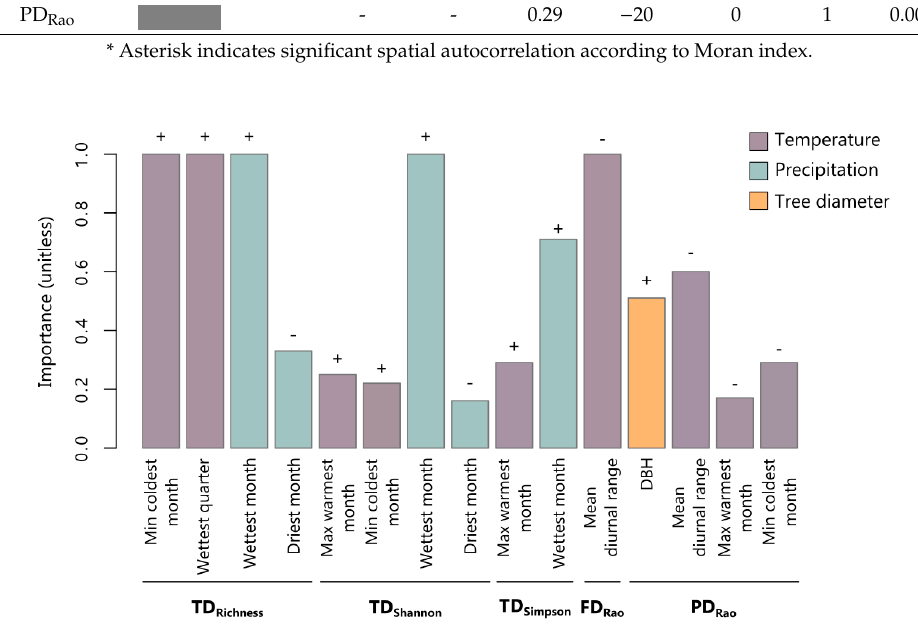
Figure 2. Relative importance (w+) of climate and landscape structure in linear models of community diversity metrics. Bar height represents the relative importance of each predictor quantified as the sum of Akaike weights (wi) of all models in which the predictor was selected and considering the number of models in which this predictor appears. Positive (+) or negative ( − ) effects of each predictor on a given diversity metric are indicated above the bar. Abbreviations: taxonomic (TD), functional (FD), and phylogenetic (PD) diversity; Inverse Simpson index (Simpson); tree diameter (DBH).